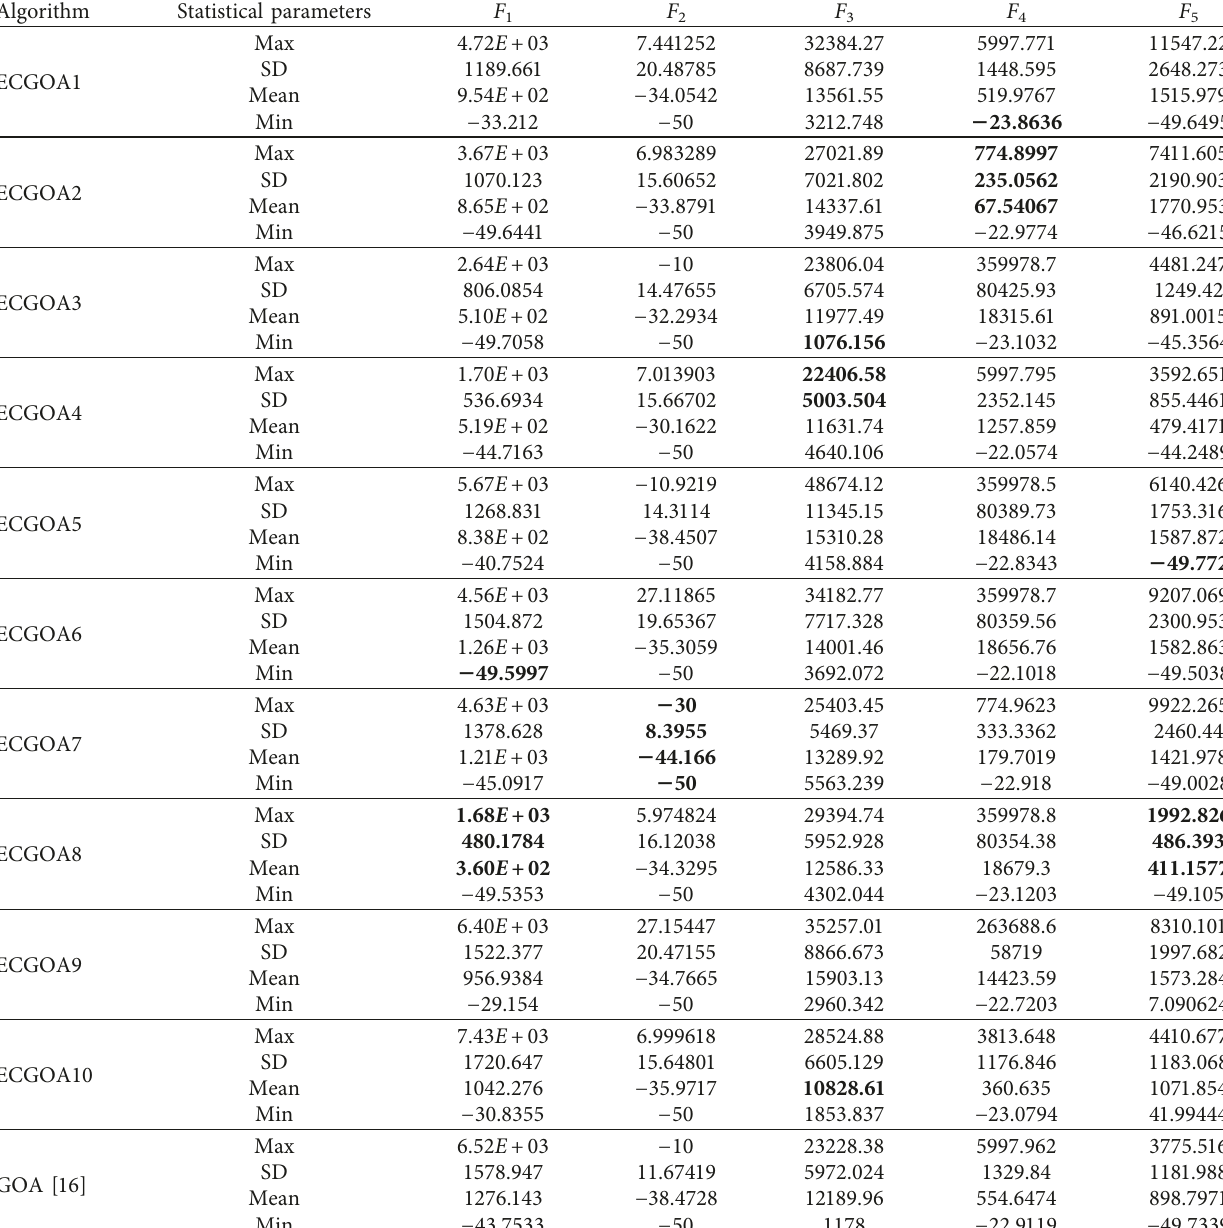
Table 3: Results and comparison of ECGOAs with GOA (30-D) on unimodal functions.